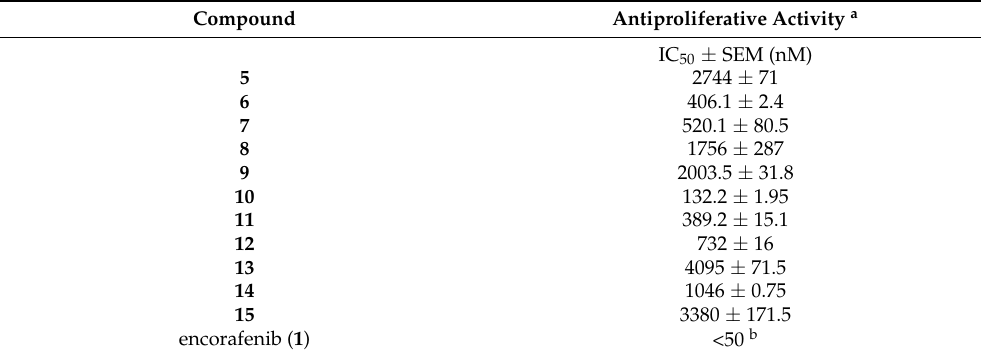
Table 1. Antiproliferative activity of encorafenib ( 1 ) and synthesized encorafenib conjugates 5 – 15 in melanoma A375 cell